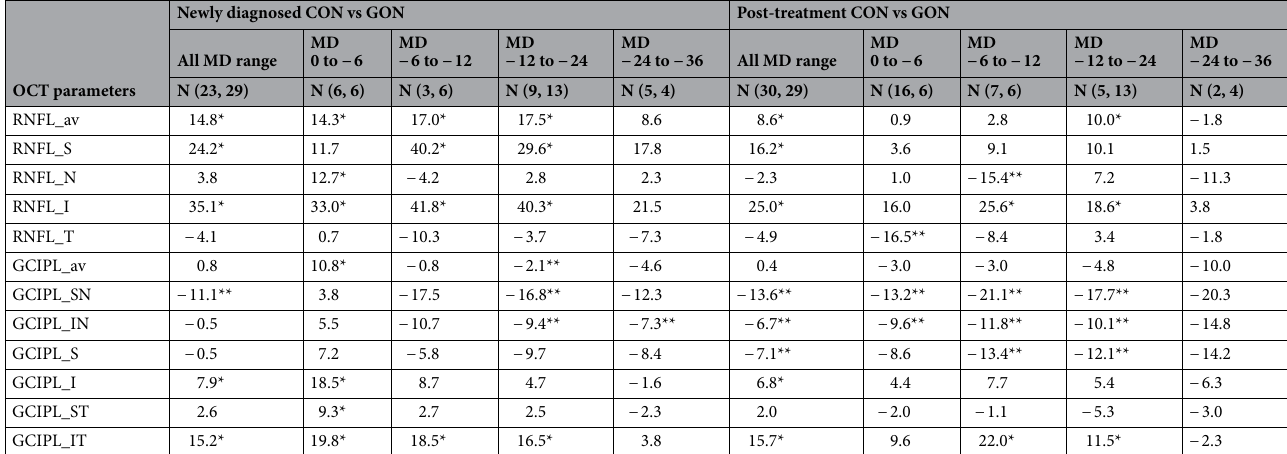
Table 3. Mean differences of the peripapillary RNFL and macular GCIPL parameter thicknesses from the comparisons of the newly diagnosed CON and GON, and of the posttreatment CON and GON. There was statistical significance for all MD range when p < 0.05, using the independent-samples t-test. Statistical significance occurred with the other MD categories when p < 0.05, using the Mann–Whitney U test. There was an alteration in the significant difference patterns when the comparisons shifted from newly diagnosed CON vs GON to post-treatment CON vs GON. GON glaucomatous optic neuropathy, CON compressive optic neuropathy, NOR healthy control, postRx post-treatment, newDx CON newly diagnosed CON eyes, RNFL peripapillary retinal nerve fiber layer parameter, S superior quadrant, I inferior quadrant, N nasal quadrant, T temporal quadrant, GCIPL macular ganglion cell-inner plexiform layer parameter, SN supero-nasal sector, IN infero-nasal sector, S superior sector, I inferior sector, ST supero-temporal sector, IT infero-nasal sector, MD mean deviation, dB decibel, N(#,#) number of eyes in each category. *Denotes positive differences; **denotes negative